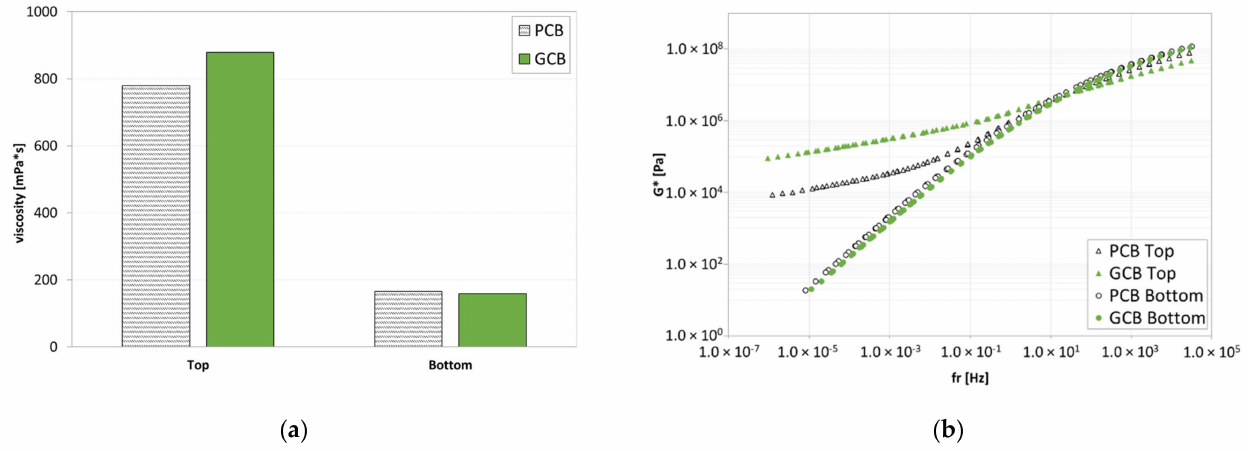
Figure 6. Analysis after tube test: ( a ) viscosity at 160 ◦ C; ( b ) master curve at 34 ◦ C.